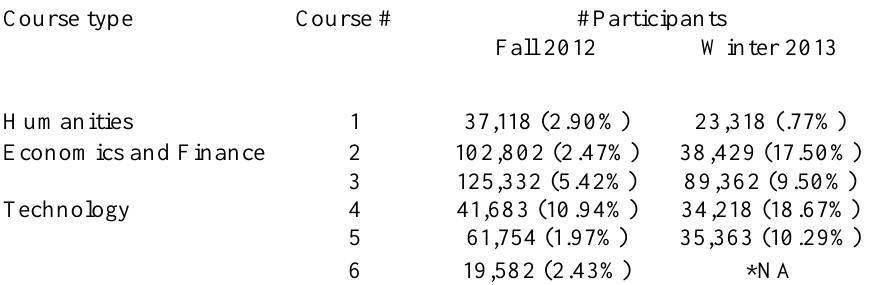
Number of Survey Participants and Response Rates for each Course by Term Offered Course